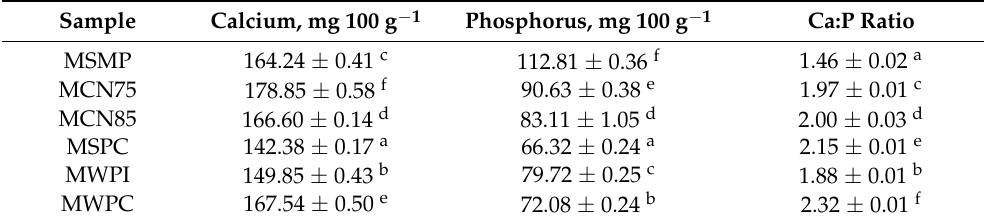
Table 2. Content of calcium and phosphorus and the Ca:P ratio in non-fermented milks enriched with protein preparations.